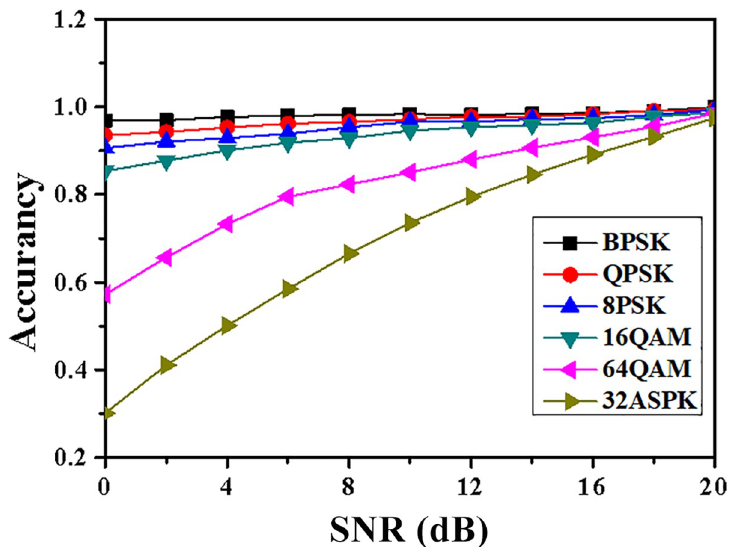
Fig 6. Variation of recognition accuracy of modulation signals at different